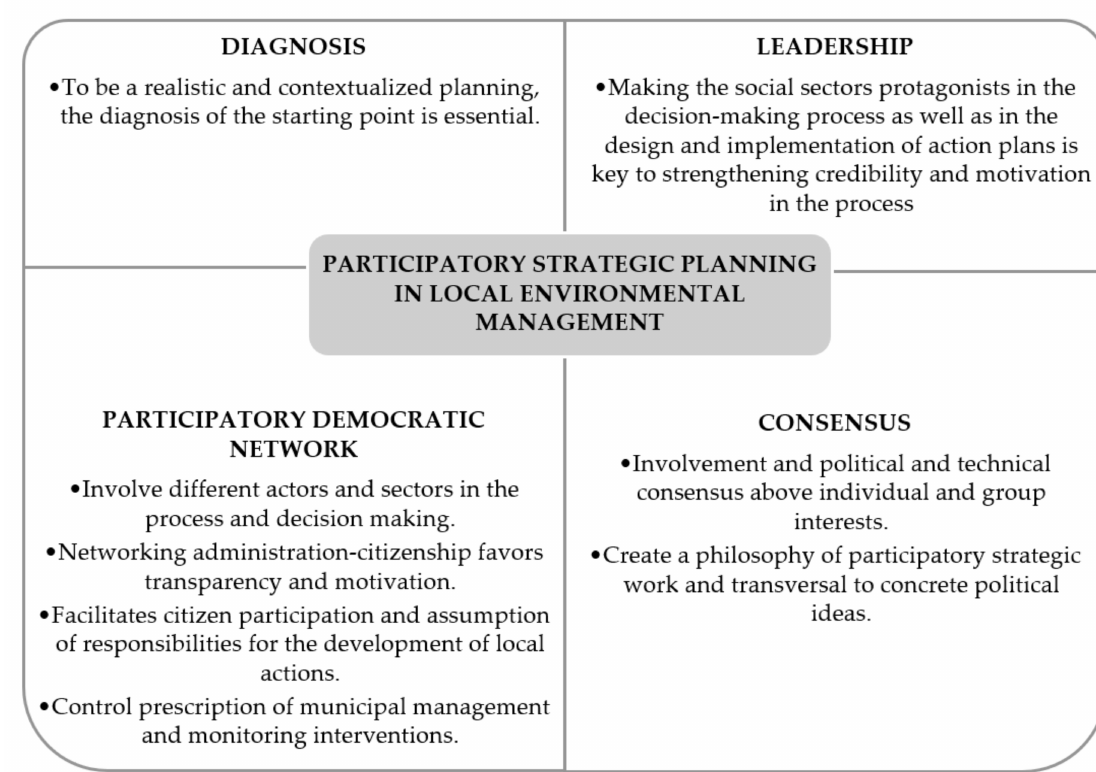
Figure 3. Participatory strategic planning in municipal environmental